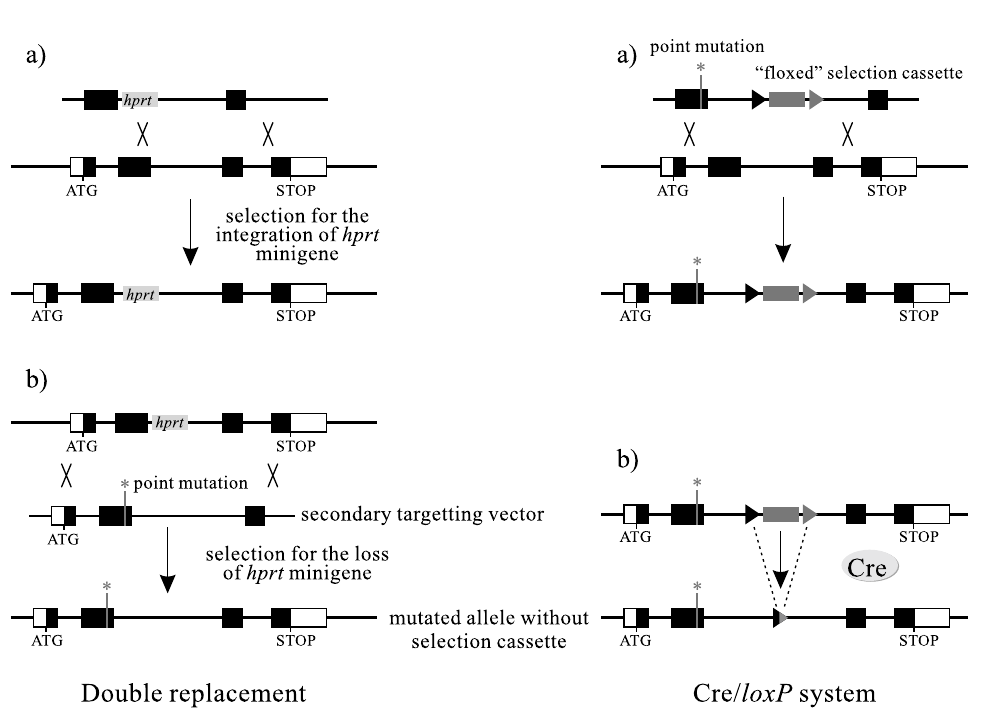
Fig. 3 – ‘‘Clean’’ mutations. The persistence in a modified allele of a selection cassette with its own promoter and regulatory sequences may affect the target locus and surrounding loci. Creation of subtle mutations (point mutations, small deletions and insertions, ...) therefore requires elimination of the selection cassette. The two strategies most used to create this type of modifications are presented in this figure. Upper panels: the double replacement strategy. This approach requires the use of hprt -ES cell lines. The first step (A) consists in introducing a cassette expressing the hprt gene in the target gene. The recombinant cells ( hprt +) are selected in the presence of HAT. In the second step (B), these cells are transfected with a replacement vector presenting a subtle mutation and devoid of a selection cassette. The homologous recombination event results in the loss of the hprt expression cassette, an event selected in the presence of 6-TG. The use of other replacement vectors carrying different modifications permits the rapid creation of several alleles for the same target gene. Lower panels: use of the Cre/ loxP system (see Fig. 4). In the first step (C), the target gene is modified by a target vector with a subtle mutation and a ‘‘floxed’’ selection cassette, i.e. surrounded by 2 loxP sites in the same orientation. Then (D) the transient expression of Cre recombinase in the recombinant cells induces deletion of the selection cassette. Apart from the desired subtle modification, only one loxP site of 34 pb persists in the final modified allele. The position of this loxP site is chosen so that it does not interfere with the expression of the target gene (generally in an